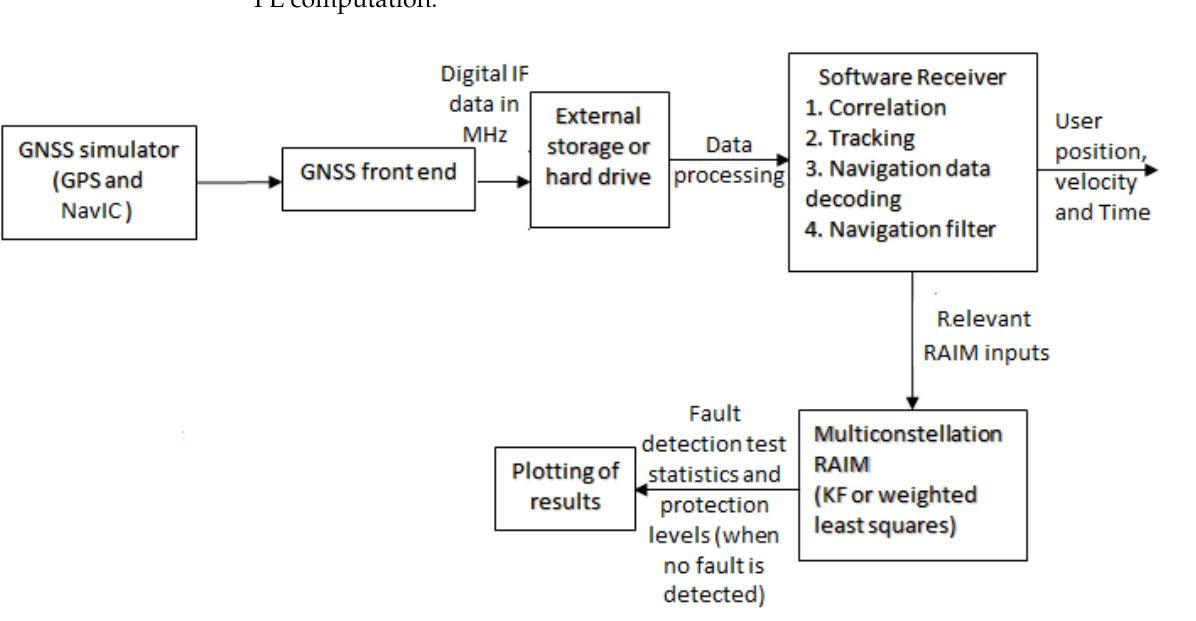
Figure 6. IF data processing block